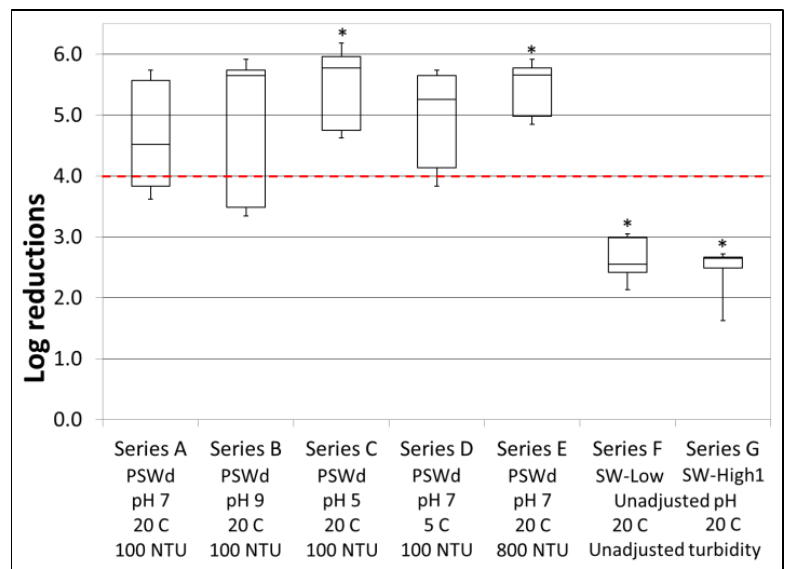
Figure 1. Box-and-whisker plots (min/max, lower/upper quartiles, and median) of average E. coli log10 reductions (LRs) with AQS treatment with different test waters and conditions. The asterisk (*) indicates that the mean bacterial concentration after treatment is below the limit of detection. The dashed line represents the LR default value to be considered “highly protective” with regard to bacterial removal/inactivation, as defined by the WHO [18]. Table 2. Summary of the AQS treatment performance trials mean microbiological results (with 95% confidence intervals) for initial (untreated) and final (after Coagulant/disinfection product (CDP) treatment—60 min for all test conditions except “cold temperature” series D in which treatment time totaled 20 min) waters.